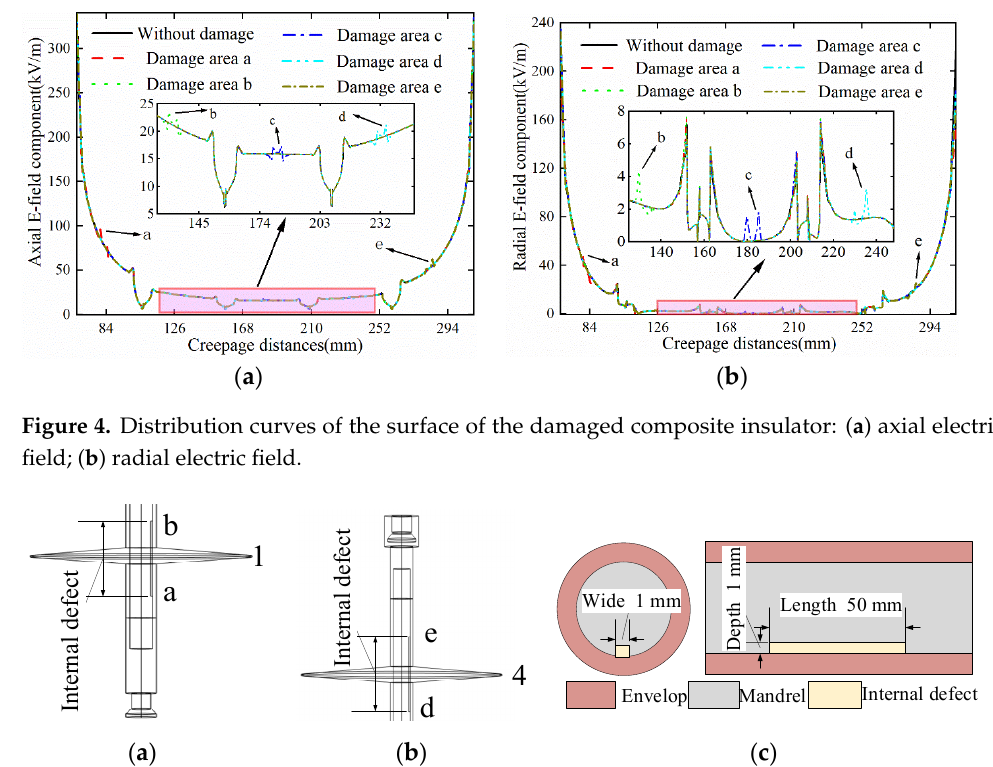
6 of 14 Figure 3. Electric field potential distribution of the damaged composite insulator at position “ a ”. As shown in Figure 4a, when the sheath of the composite insulator is damaged at positions “ a ” to “ e ”, the higher axial electric field strength is located near the HV and LV ends of the insulator, while the electric field strength of the middle part of the insulator is